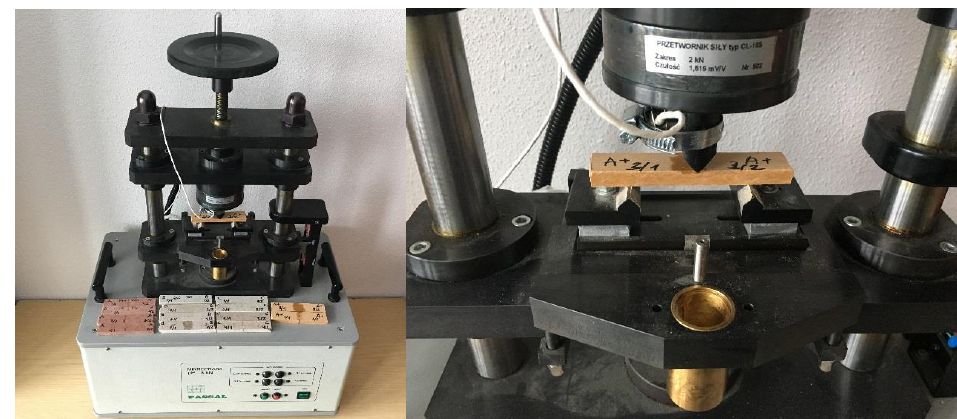
Figure 1. Test stand for bending strength measurements, and fibre-cement board during test.